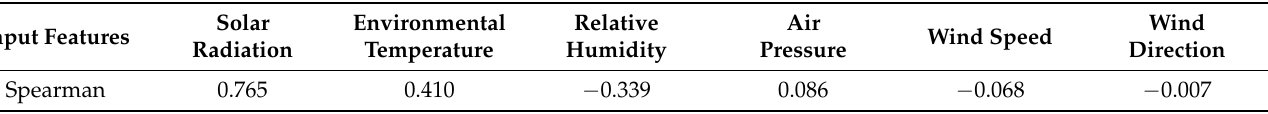
Spearman correlation coefficient between meteorological factors and photovoltaic power